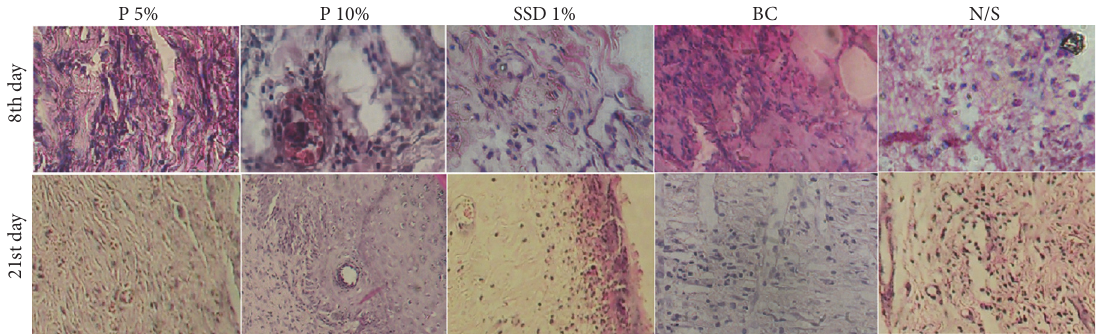
Figure 4: Comparison of the histopathology of biopsy samples from second-degree burns on 8 and 21 days after treatment with basic cream (BC), no treatment or normal saline (N/S), standard silver sulfadiazine treatment (SSD 1%), and Punica granatum 5% (P 5%) and Punica granatum 10% (P 10%) creams treatment. Neovascularization activity and fibroblastic proliferation were better in P 5%, P 10%, and SSD 1% cream compared with N/S and BC groups on the 8th day. Also, degree of granulation tissue was better in these groups. The thickness of the granular cell layer and the epidermal thickness degree in the wound of Punica 10% and SSD 1% wound treatment were better than in other groups on the 21st